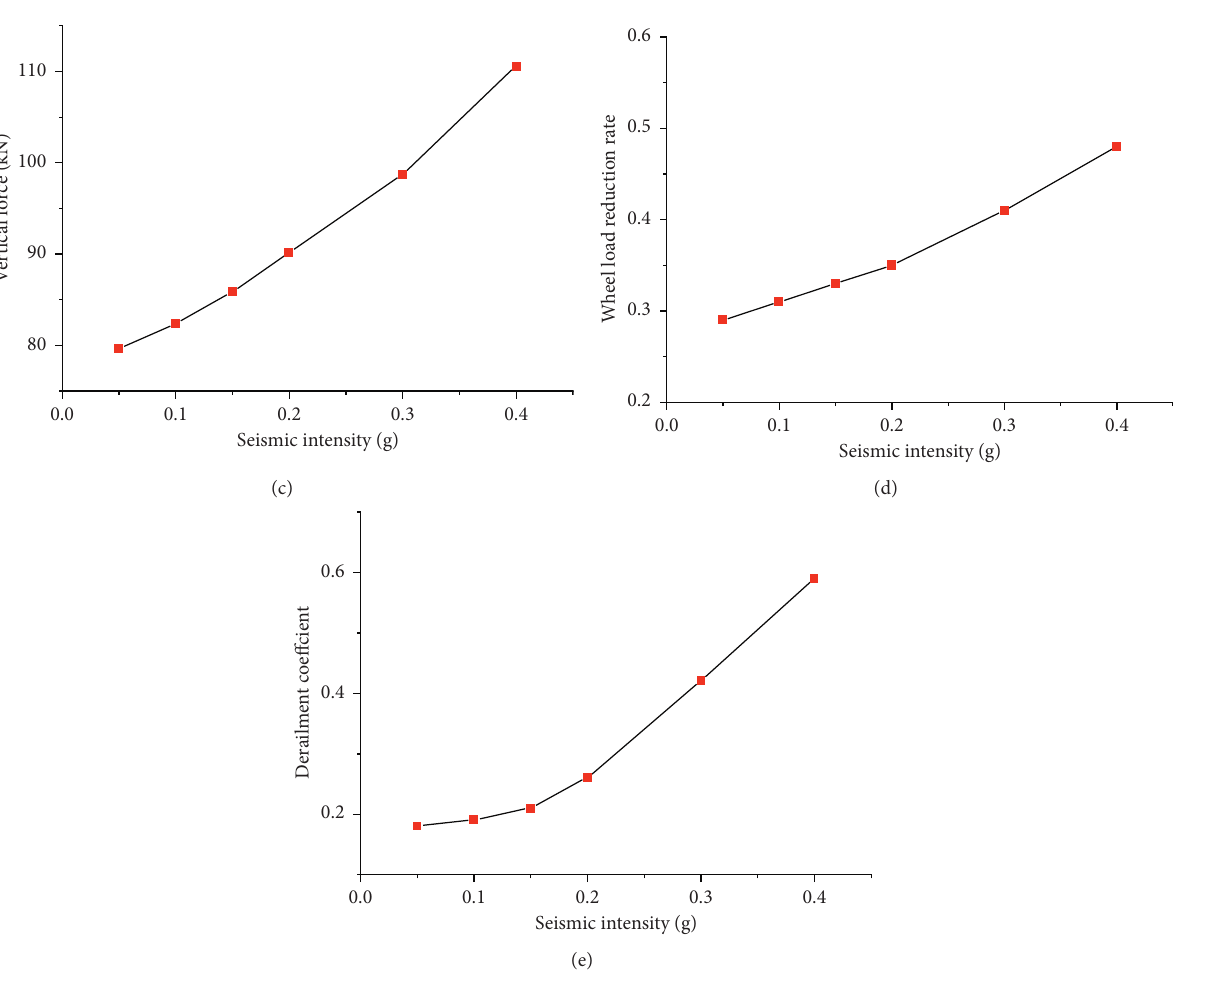
Figure 21: Changes in dynamic response indexes under the Tianjin wave. (a) Changes in lateral acceleration. (b) Changes in lateral force. (c) Changes in vertical force. (d) Changes in wheel load reduction rate. (e) Changes in derailment